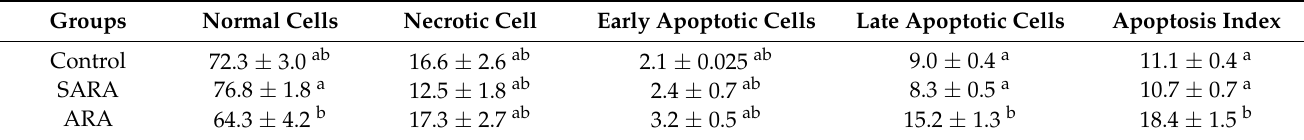
Table 1. Effect of pH treatment on BREC apoptosis